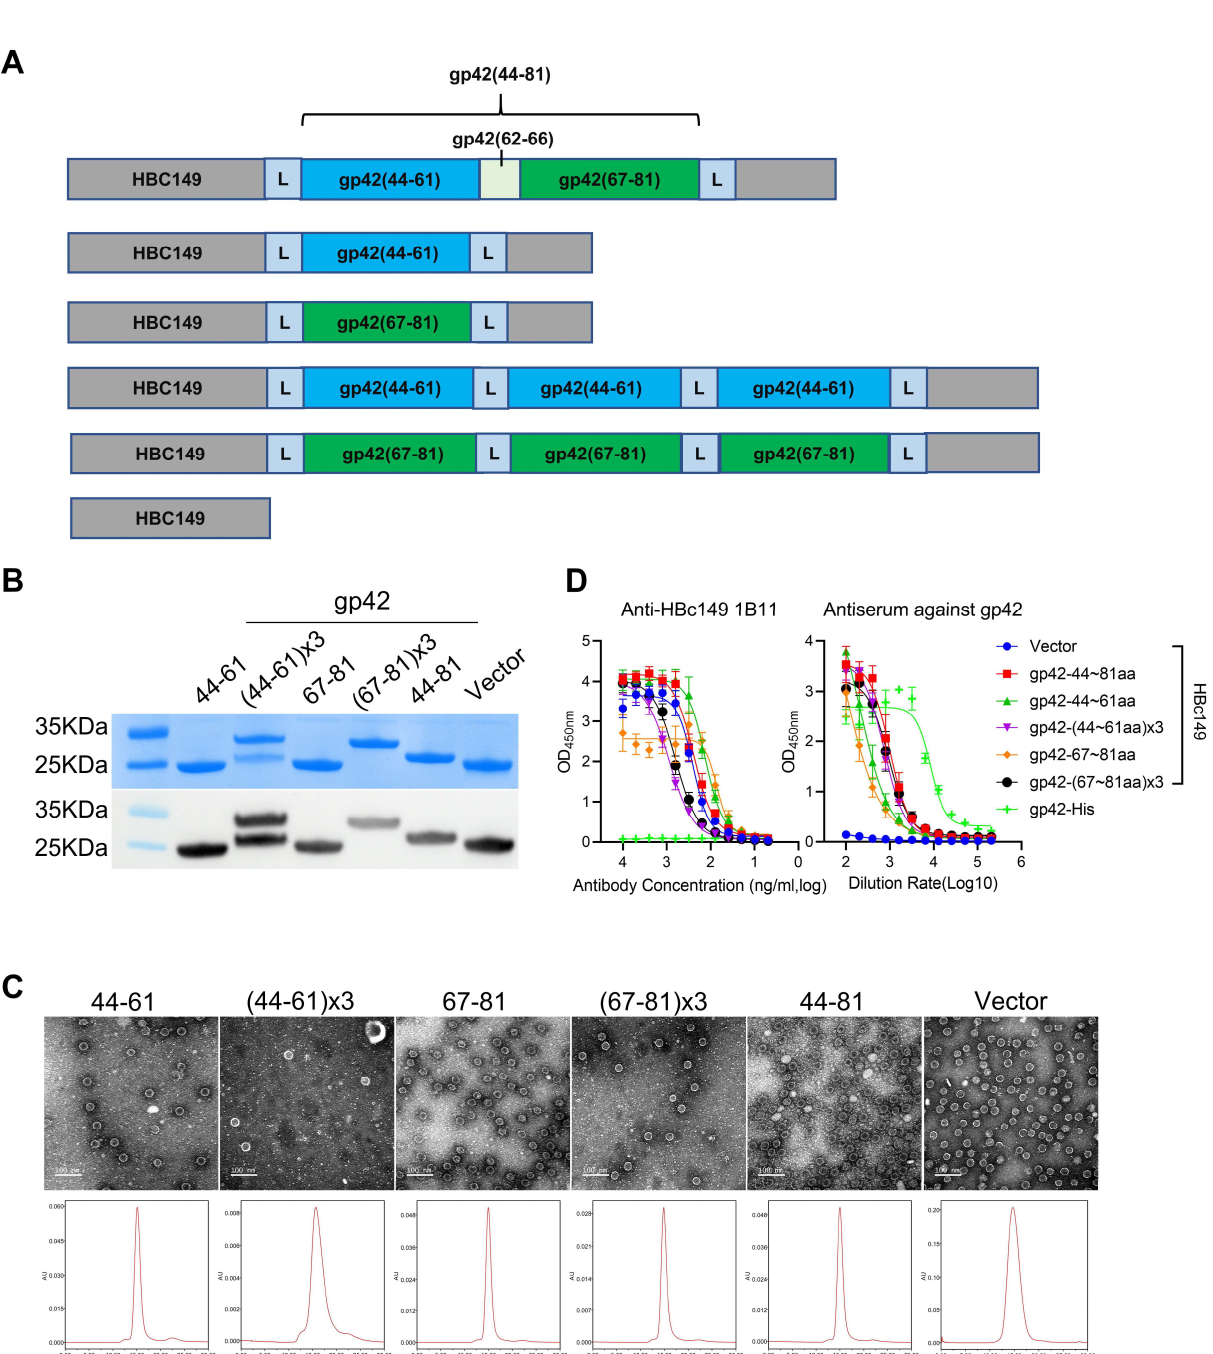
Figure 5. Generation and characterization of chimeric VLPs. ( A ) Schematic diagram illustrating the design of chimeric VLPs carrying the peptides from gp42 N-terminal region. gp42-44-61aa is labelled in cyan and gp42-67-81aa is labelled in green. ( B ) SDS-PAGE and Western blot analysis of fusion proteins. Anti-HBc149 mAb 1B11 was used for particle detection. ( C ) The size and morphology analysis evaluated by transmission electron microscope (TEM) and high-performance liquid chromatography (HPSEC). ( D ) Reactivities of chimeric VLPs with anti-gp42 immune serum and anti-HBc149 mAb 1B11 using ELISA assay.